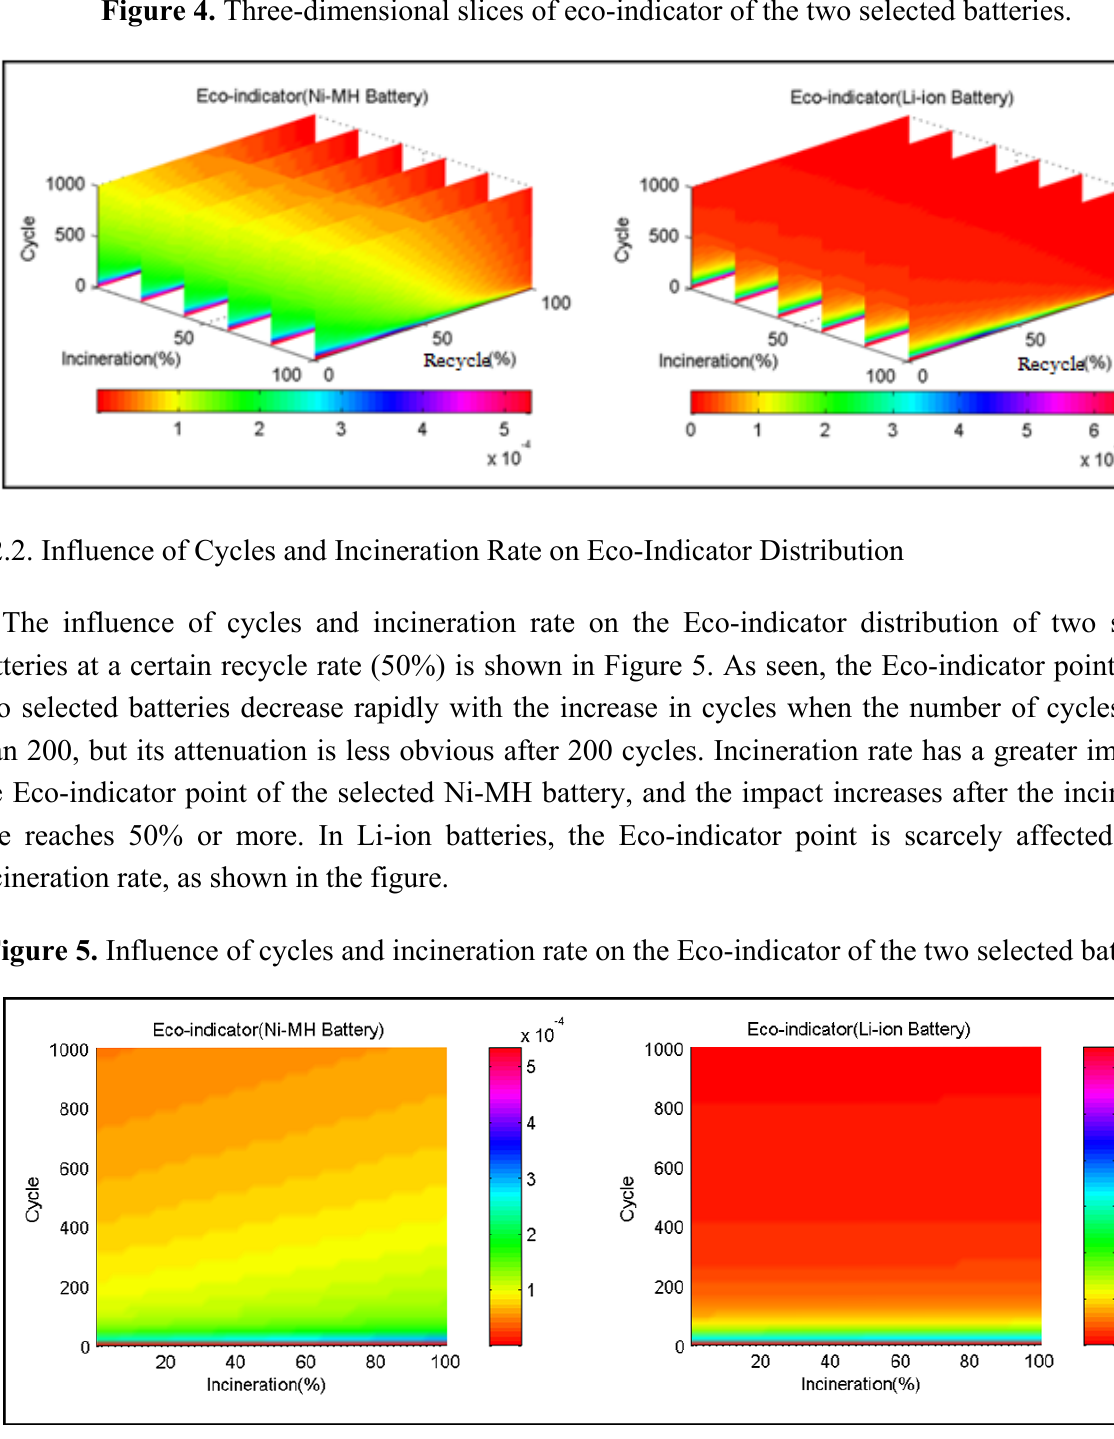
Figure 4. Three-dimensional slices of eco-indicator of the two selected batteries.